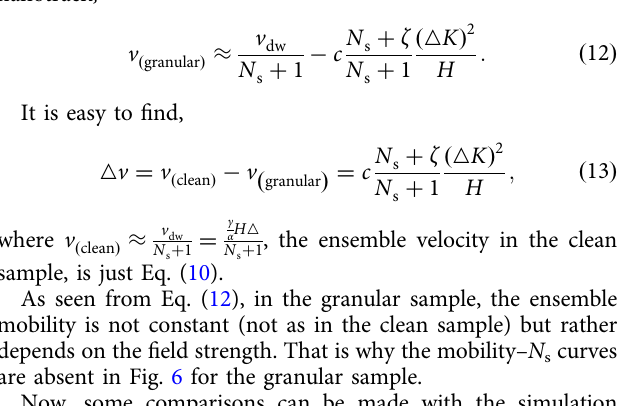
þ N s (cid:2) 1 δ 2 w